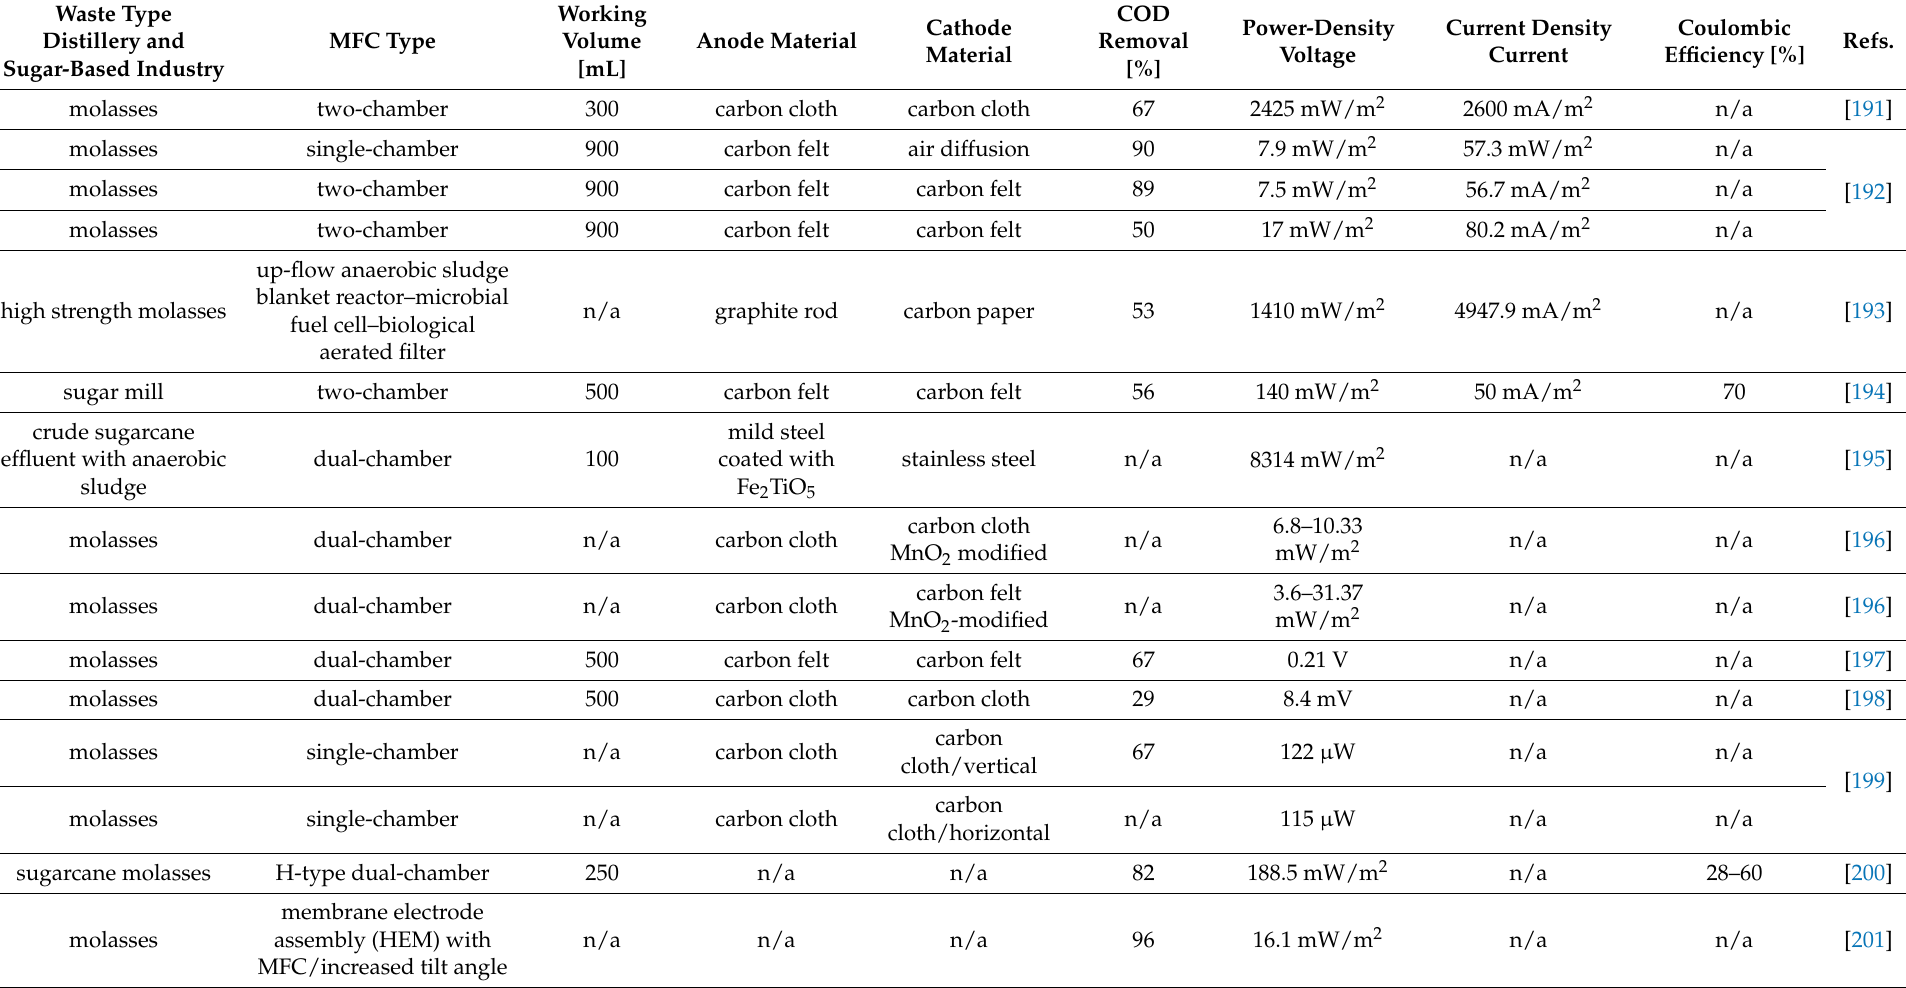
Table A7. Summary of studies reporting use of distillery and sugar-based industry waste in